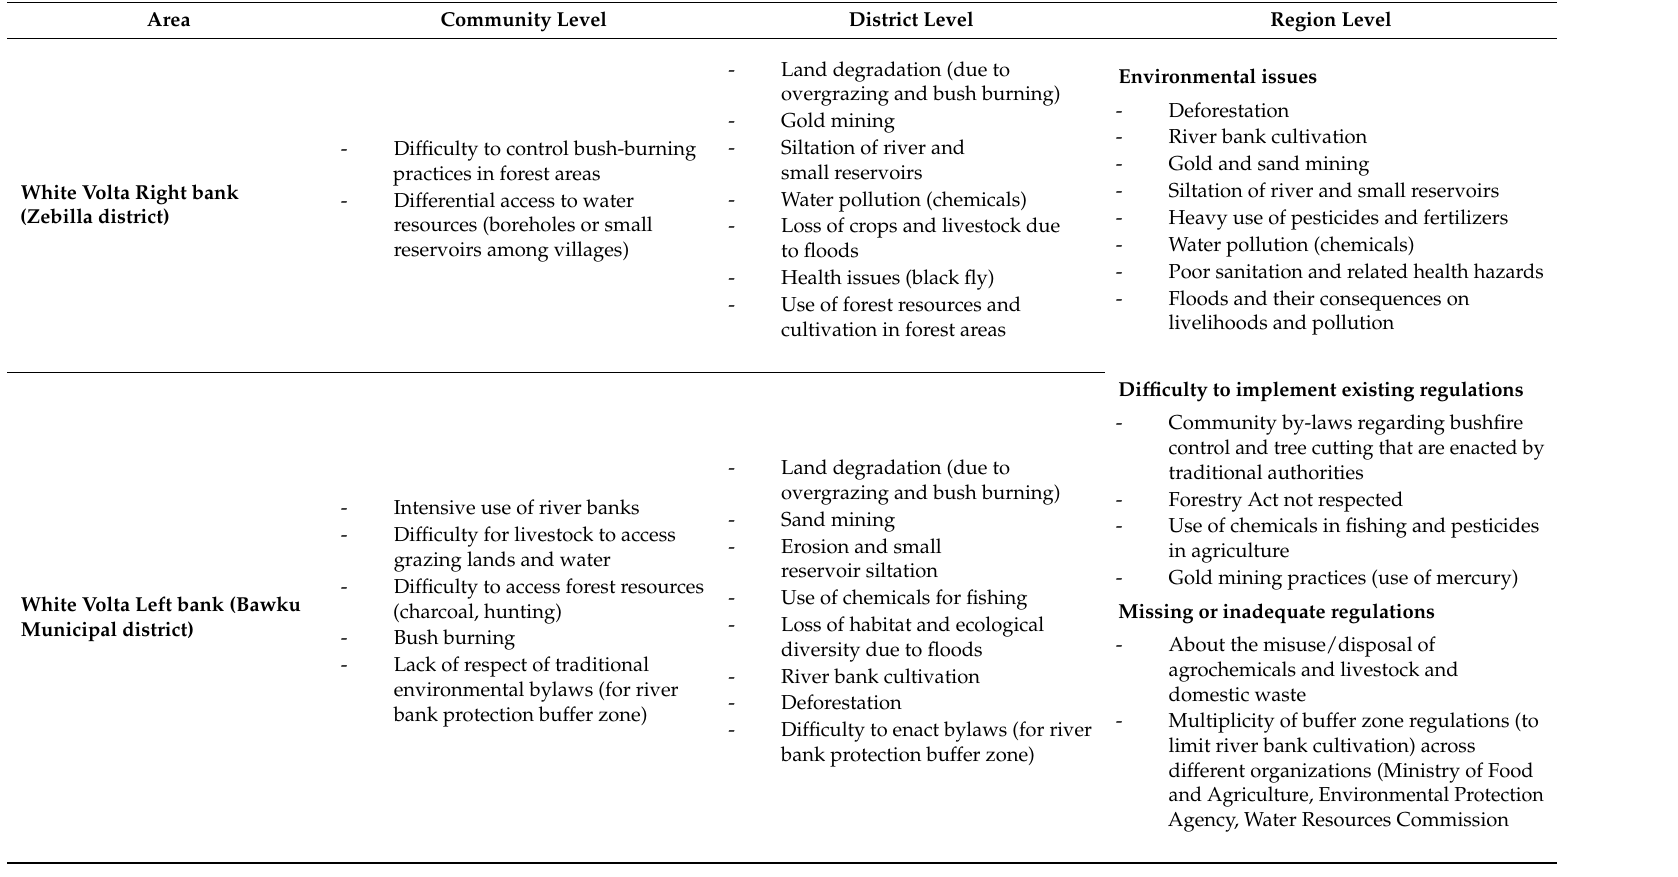
Table 2. Issues identified by the participants during the first participatory workshop. WRC: Water Resource